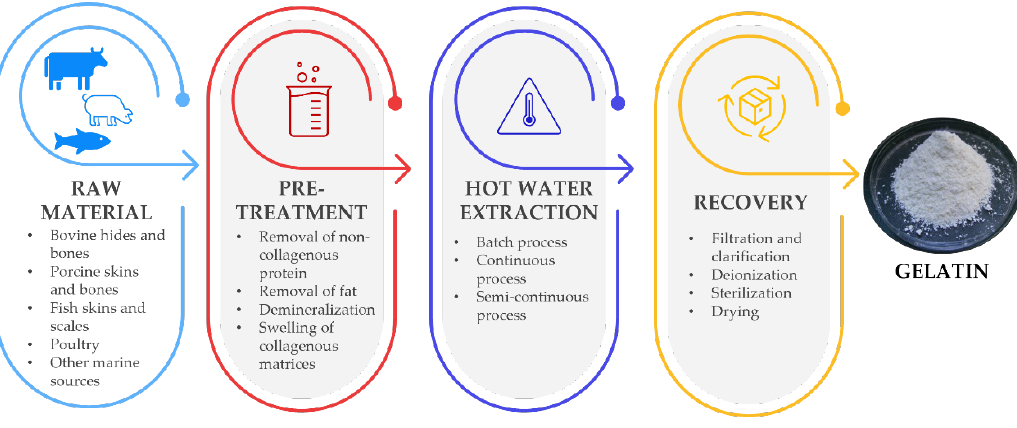
Figure 2. The general gelatin extraction procedure.